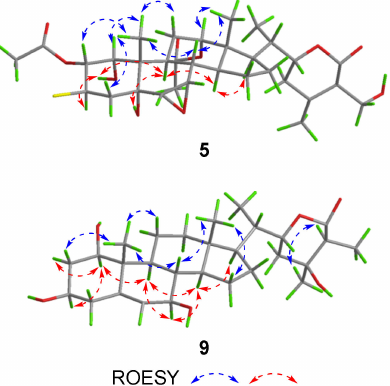
Figure 6. Key ROESY correlations for compounds 5 and 9